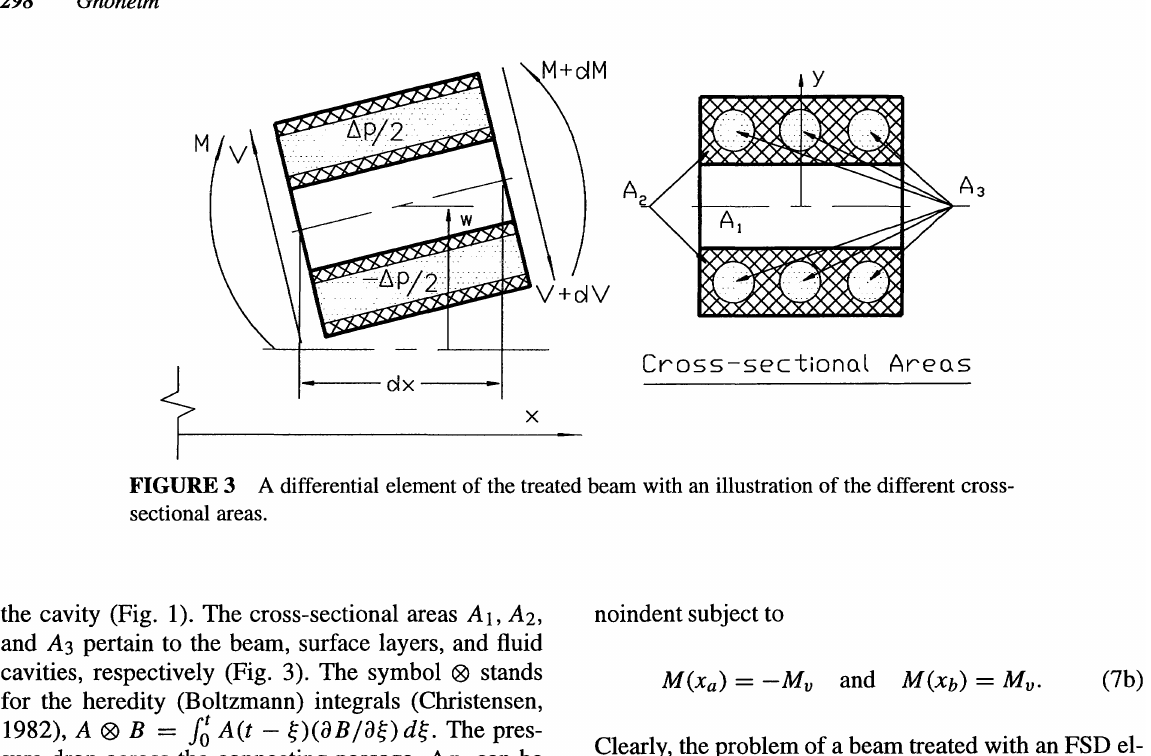
FIGURE 3 A differential element of the treated beam with an illustration of the different cross sectional